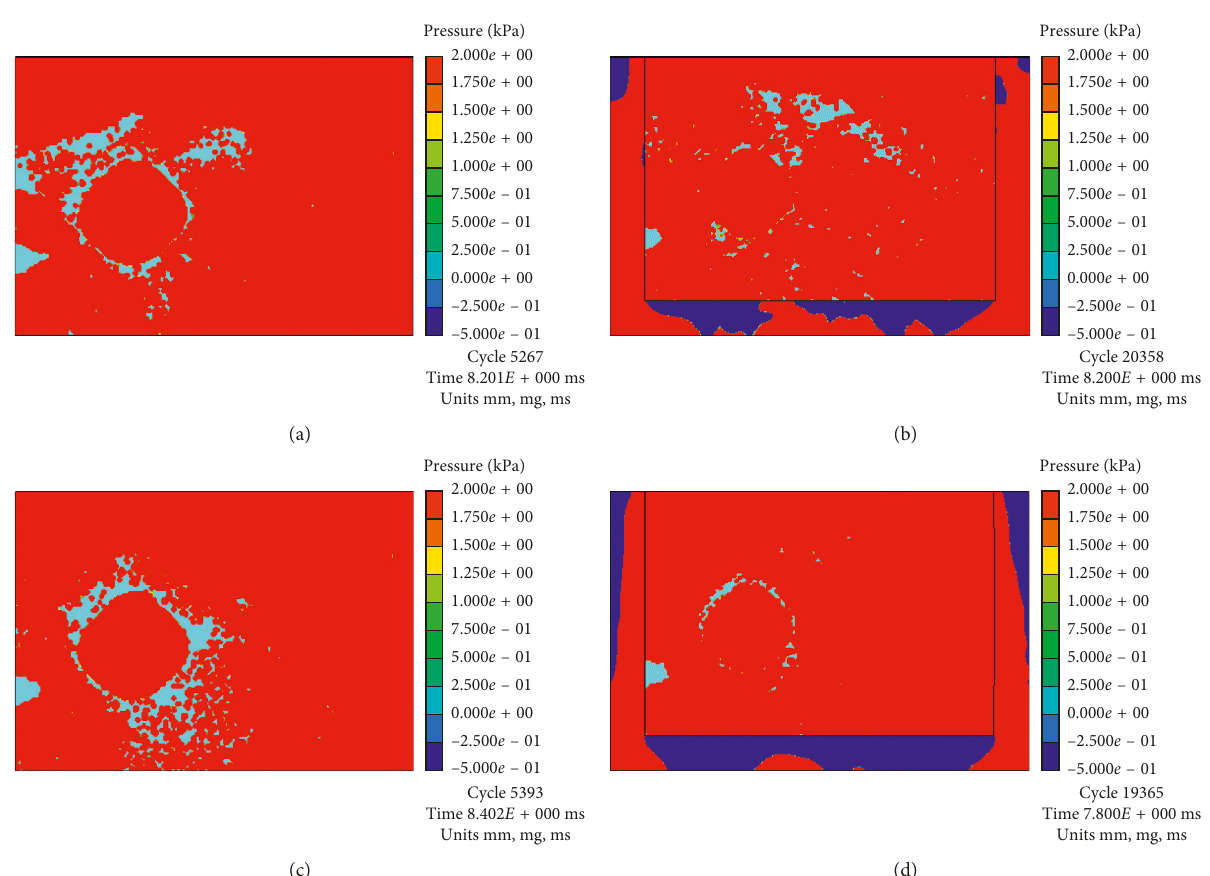
Figure 13: Four pressure cloud maps at the moment that each of bubbles had the maximum radius under 50 g : (a) UE-Num-15, (b) UE- Num-16, (c) UE-Num-17, and (d)